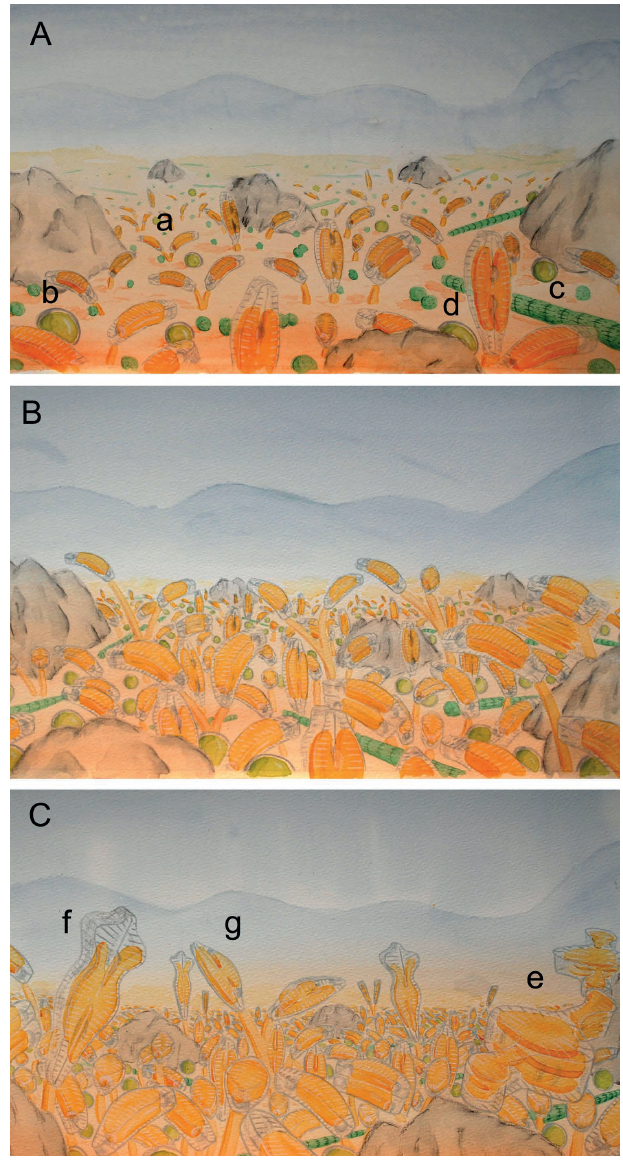
Figure 6 – The colonisation of bare rock surfaces by algae in Wastwater, visualised from experimental data in King (1999): A, a sparse community of colonising algae after two weeks; B, after three weeks much of the space has been filled in but there has been little change in composition. C, after six weeks, however, competition for resources leads to a situation which favours stalked and filamentous diatoms. Key to taxa: a, Achnanthidium minutissimum ; b, spherical non-motile green algae; c, narrow Phormidium -like cyanobacterial filament; d, Gomphonema parvulum complex; e, Tabellaria flocculosa ; f, Gomphonema acuminatum ; g, Cymbella sp. This figure is not covered by the Creative Commons License (CC BY 4.0) of this paper and copyright is held by Martyn